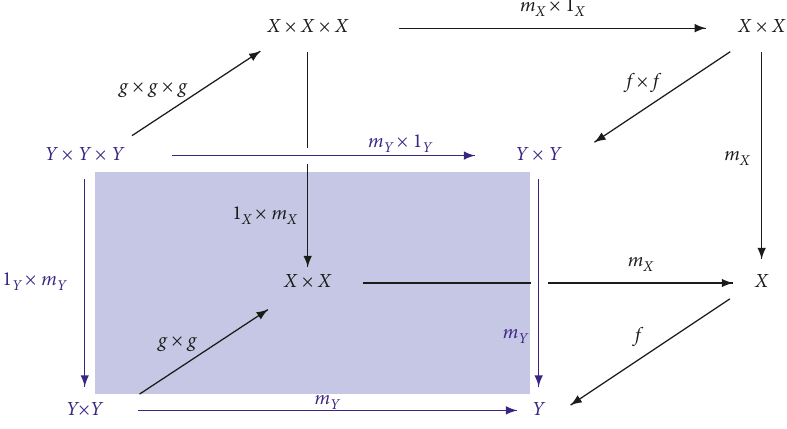
Figure 7: A commutative diagram.